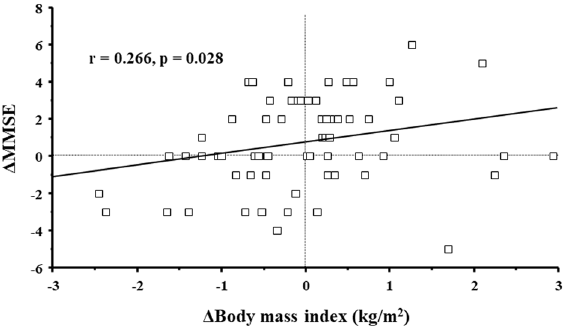
Figure 1. Correlation between changes in MMSE score and changes in body mass index from the study initiation to the second measurement. ΔMMSE MMSE score at the second measurement − MMSE score at the study initiation, ΔBody mass index body mass index at the second measurement − Body mass index at the study initiation, MMSE Mini-Mental State Examination.